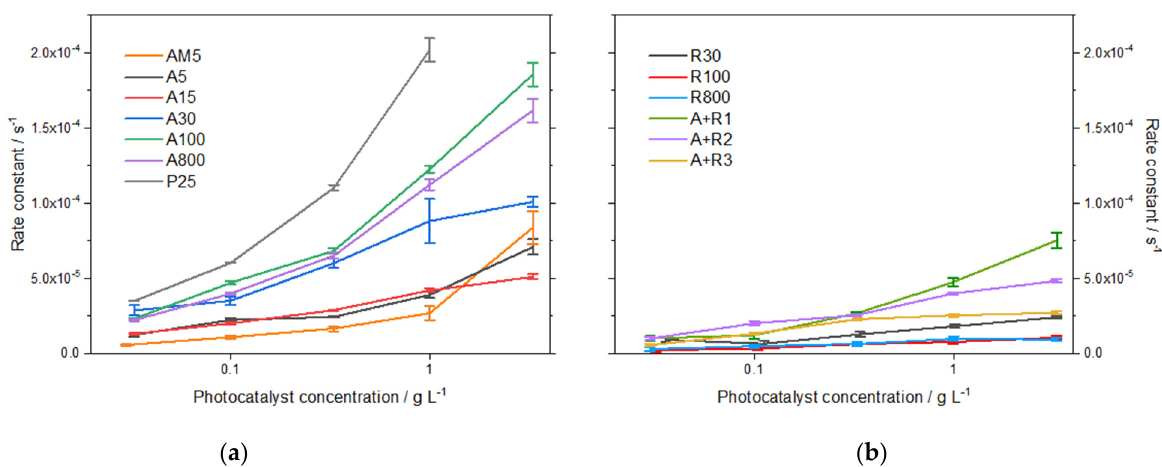
Figure 3. Rate constants of ampicillin photocatalytic degradation in aqueous suspensions of all photocatalytic powders ( a , b ).